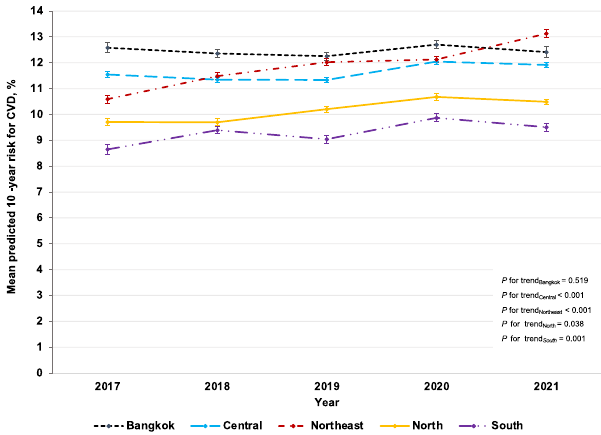
Figure 3. Age- and sex-adjusted mean (%) of the predicted 10-year risk for cardiovascular diseases (CVD) among Royal Thai Army personnel stratified by region from 2017 to 2021.